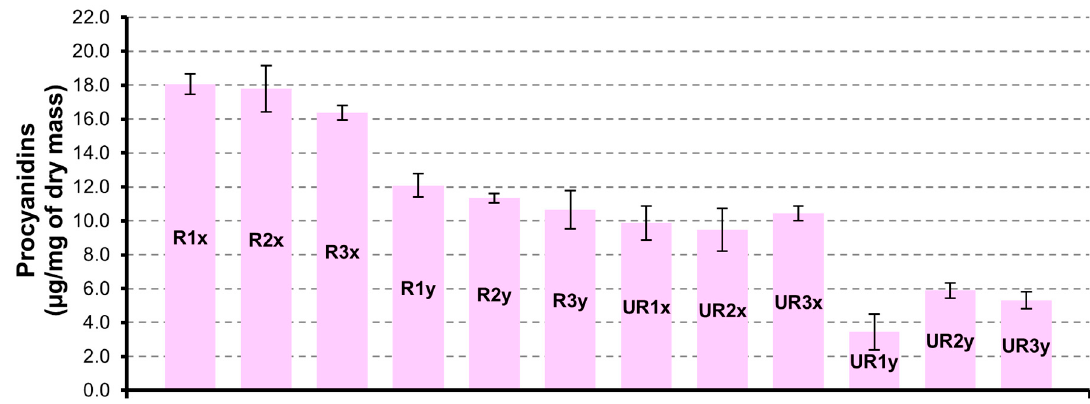
Figure 3. Procyanidins quantification in CAR-R and CAR-UR extracts; 1 (24 h), 2 (48 h) and 3 (72 h) time of drying; x (3 h) and y (6 h) time of extraction.